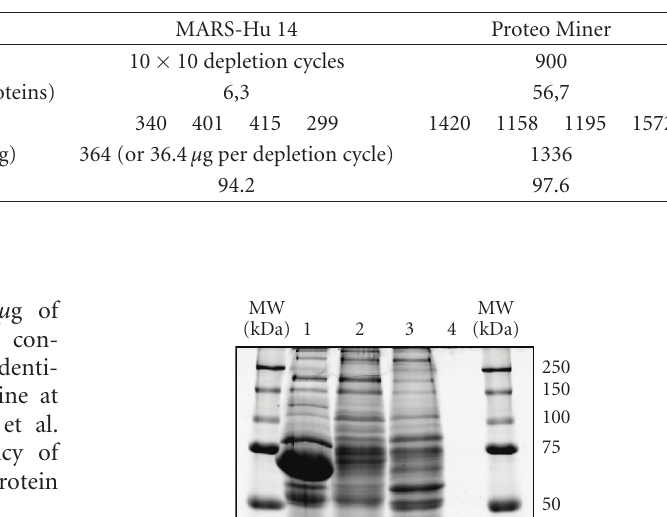
Table 1: Protein recovery after plasma prefractionation using immunoa ffi nity depletion of high-abundant proteins or hexapeptide ligand library treatment. Protein content was estimated using FluoroProfile Protein Quantification Kit.